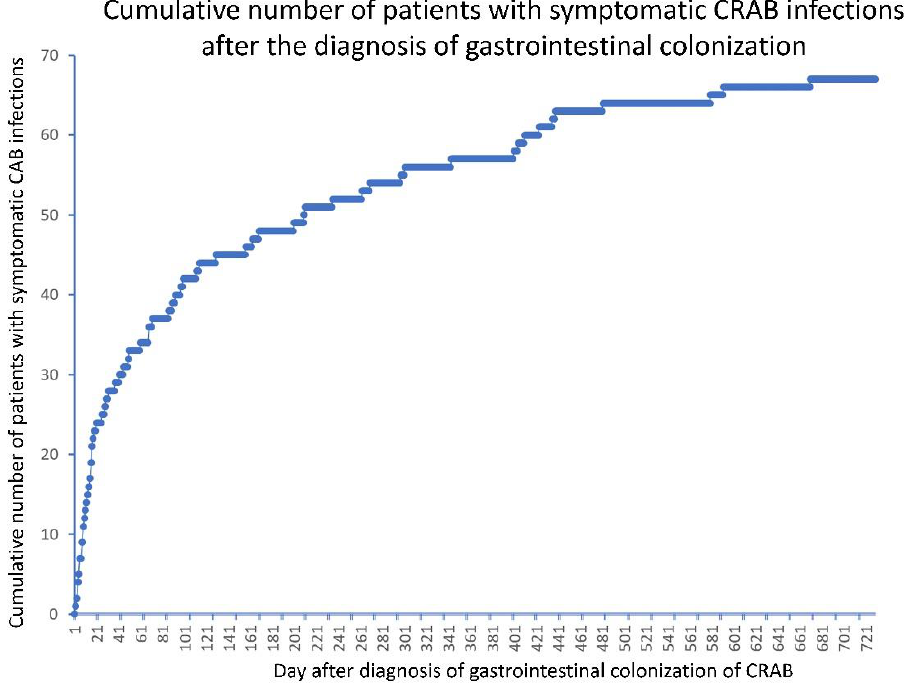
Figure 2. Patients with symptomatic carbapenem-resistant A. baumannii (CRAB) infections after the diagnosis of gastrointestinal colonization.